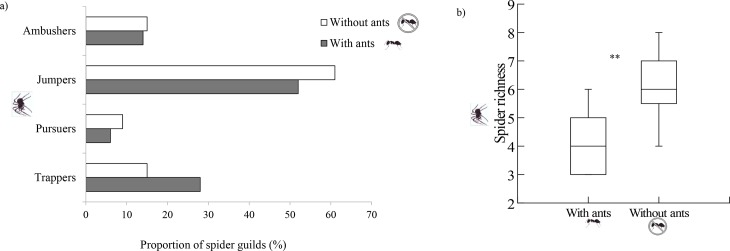
Spider richness.(a) Spiders richness and the proportion of different spider guilds in plants with (control group) and without ants (spider group); (b) spider richness in plants with (control group) and without ants (spider group), richness refers to the number of species per tree. ** indicate significant different—Student's t-test.